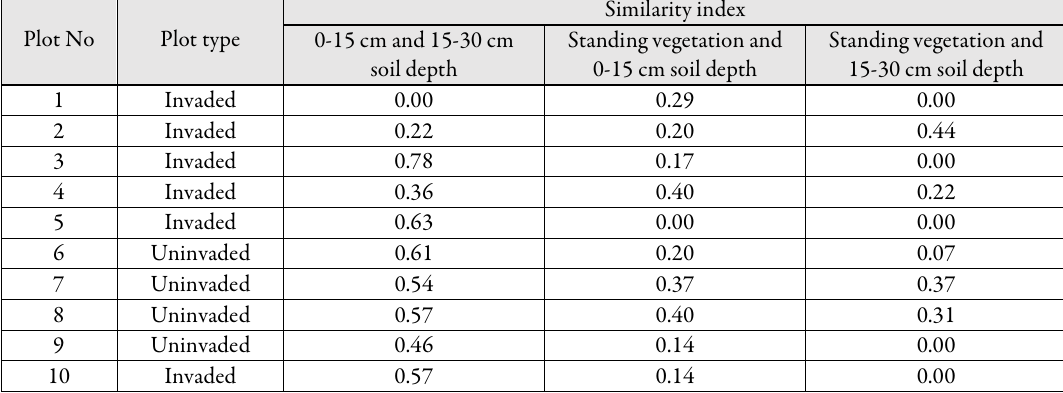
Table 2. Similarity index in species composition at different soil depths and between standing